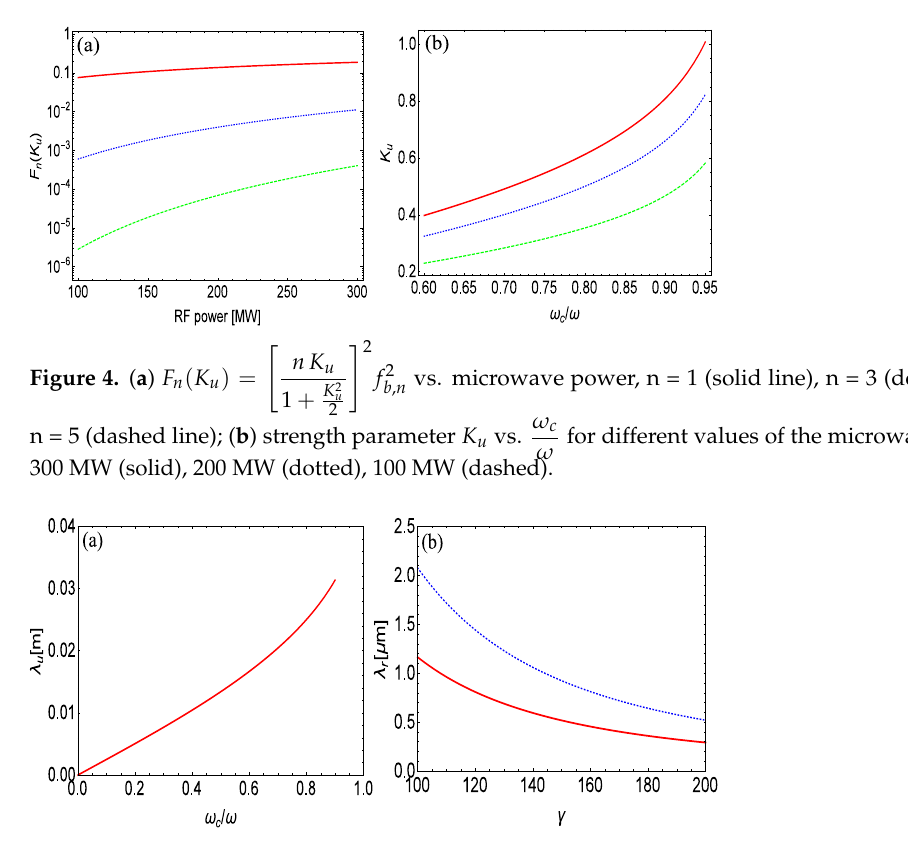
Figure 5. ( a ) Equivalent undulator period vs. x = ω c / ω ; ( b ) resonant wavelength vs. γ (dot x = 0.9, √ continuous x = 1/